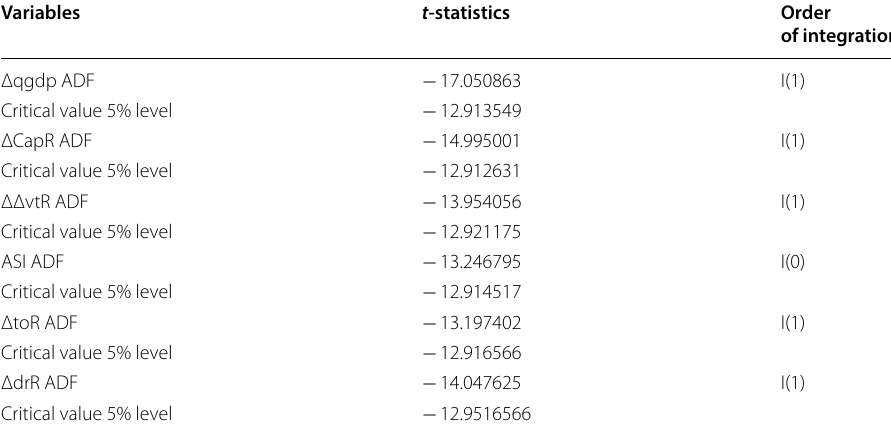
Table 7 Augmented Dickey–Fuller Unit Root Test results (original model)